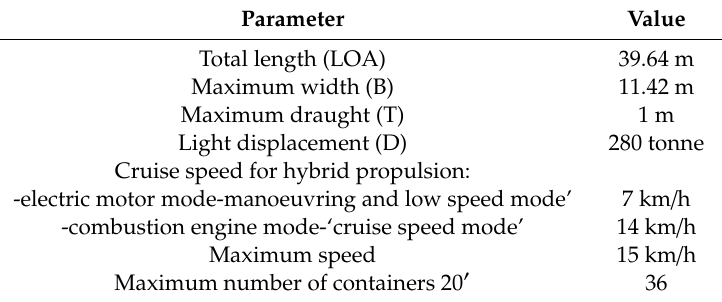
Figure 2. General plan of the case study vessel (inland-coastal container ship with hull length of LOA = 39.64 m). Table 1. Basic parameters of case study vessel.